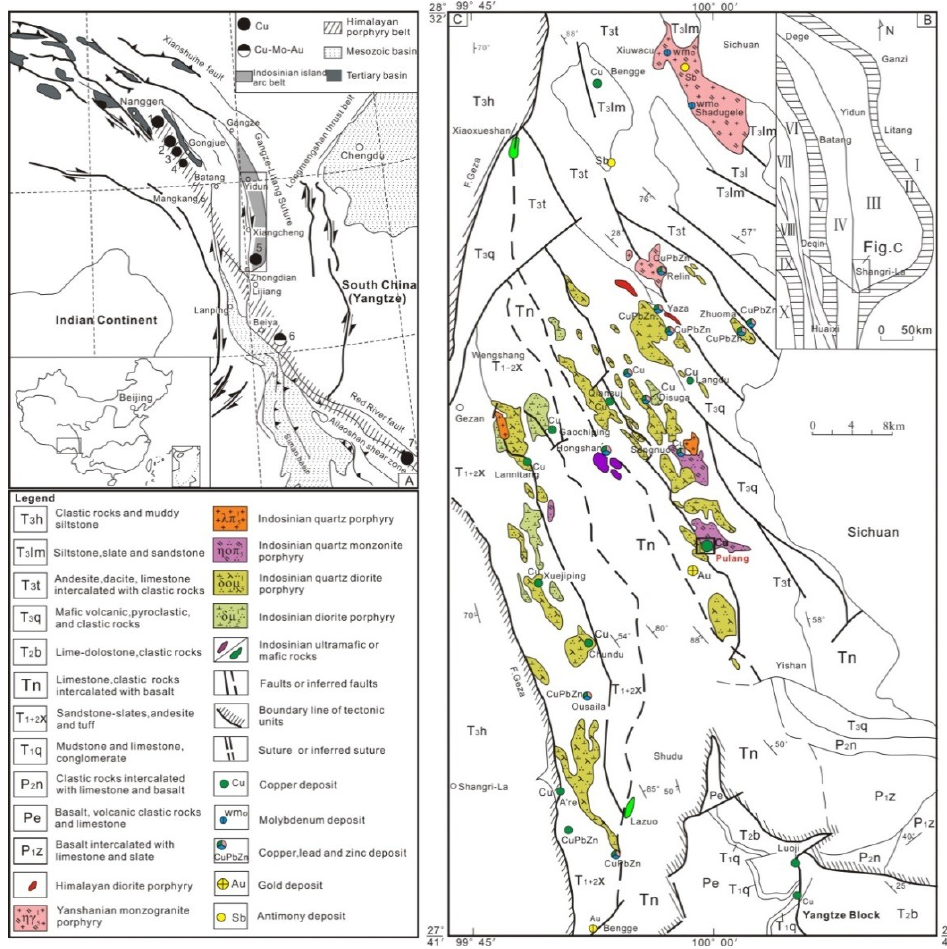
Figure 1. ( A ) Regional tectonic map of the Zhongdian island-arc zone (based on Li et al. [20]), showing the Indosinian and Himalayan porphyry Cu belts and deposits numbered as follows: 1 = Yulong; 2 = Malasongsuo; 3 = Duoxiasongsuo; 4 = Mamupu; 5 = Pulang; 6 = Machangqing; 7 = Tongchang. ( B ) Tectonic location map and ( C ) regional geology map of the Pulang Cu deposit (based on Wang et al. [34]). I = Yangtze block; II = Garze–Litang suture zone; III = Yidun arc belt; IV = Zhongza block; V =